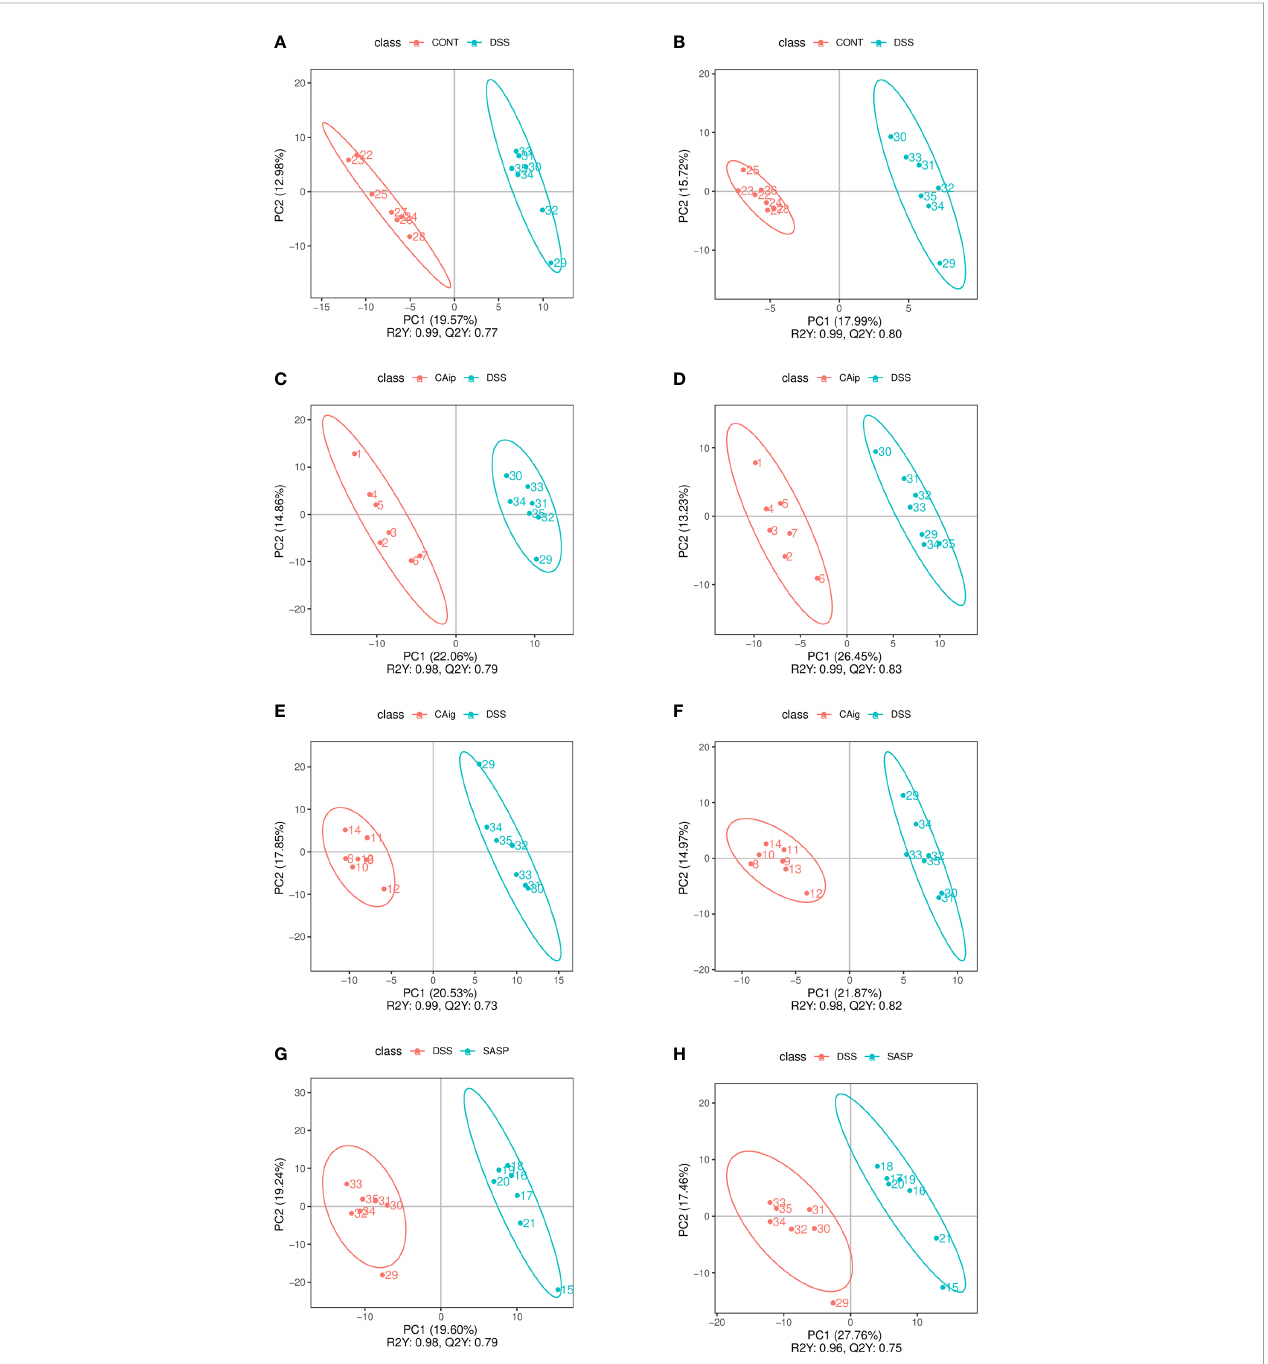
FIGURE 6 PLS-DA analysis of Control vs. DSS (A, B) , DSS vs. CAip (C, D) , DSS vs. CAig (E, F) , and DSS vs. SASP (G, H) groups in positive ion and negative ion